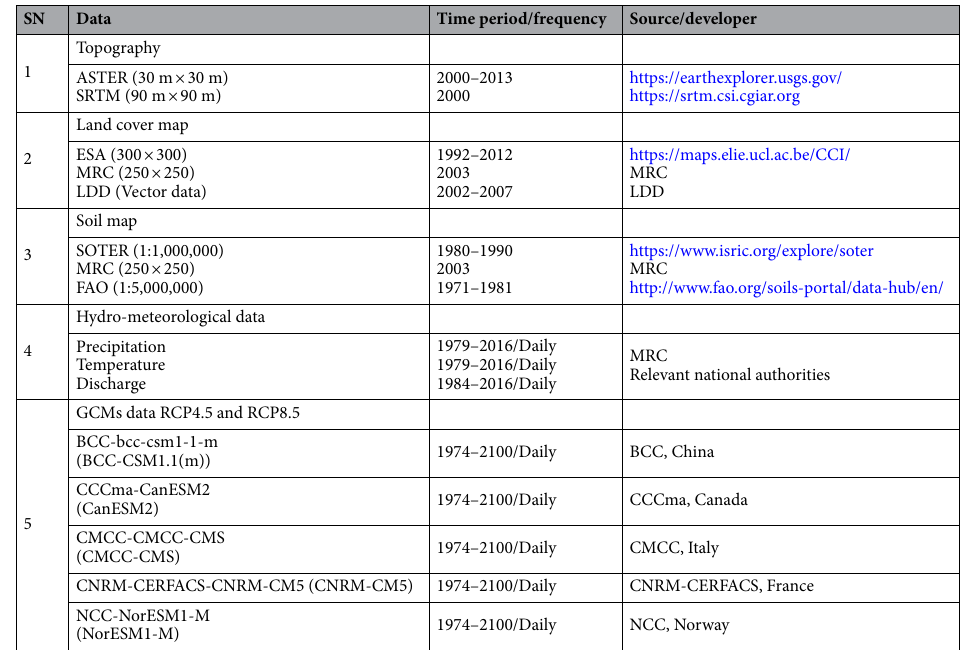
Table 1. Data and corresponding source. ASTER GDEM, Advanced Spaceborne Thermal Emission and Reflection Radiometer Global Digital Elevation Model; SRTM, Shuttle Radar Topography Mission; ESA, European Space Agency; MRC, Mekong River Commission; LDD, Land Development Department, Thailand; SOTER, Soil and Terrain; BCC, Beijing Climate Center; CCCma, Canadian Centre for Climate Modelling and Analysis; CMCC, Centro Euromediterraneo sui Cambiamenti Climatici; CNRM-CERFACS, Centre National de Recherches Météorologiques—Centre Européen de Recherche et de Formation Avancée en Calcul Scientifique; NCC, Norwegian Climate Centre; RCP, Representative Concentration Pathway. Time period of hydro-meteorological variables is the total range from all basins (detailed in Supplementary Table